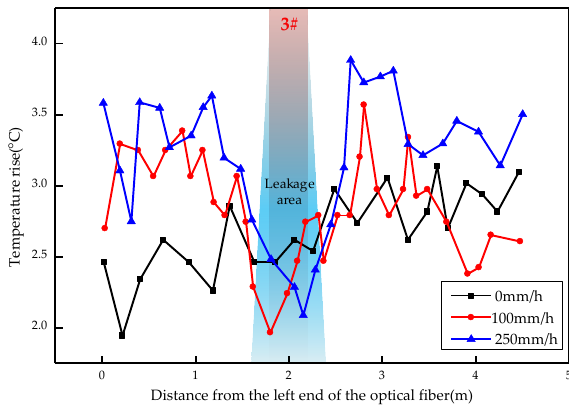
Figure 12. Temperature increase curve of seepage flow velocity at 250 mm/h.